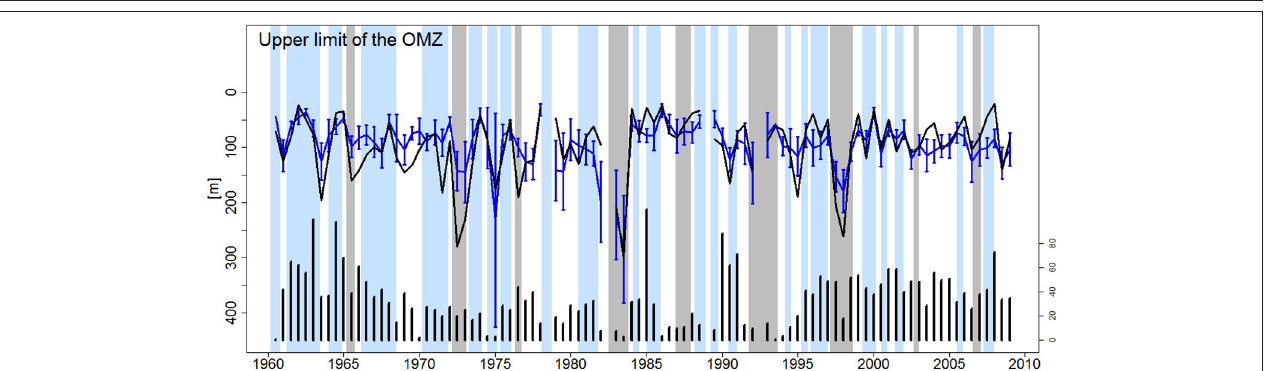
FIGURE 4 | ZO2 time series (in meters). Data was averaged each semester for IMARPE (blue line) and model output (black line) in a coastal box (6 ◦ S − 16 ◦ S and 100km from the coast). Error bars represent the standard deviation from IMARPE data. Black bars (at the bottom of the figure) represent the coverage ratio (number of sampled points/ total number of points). The modeled ZO2 was computed using the same sampling as IMARPE observations (gaps mean there is no data). Gray and blue shading represent EN and LN period, respectively.